Question: Does the figure show an increasing or a decreasing trend?
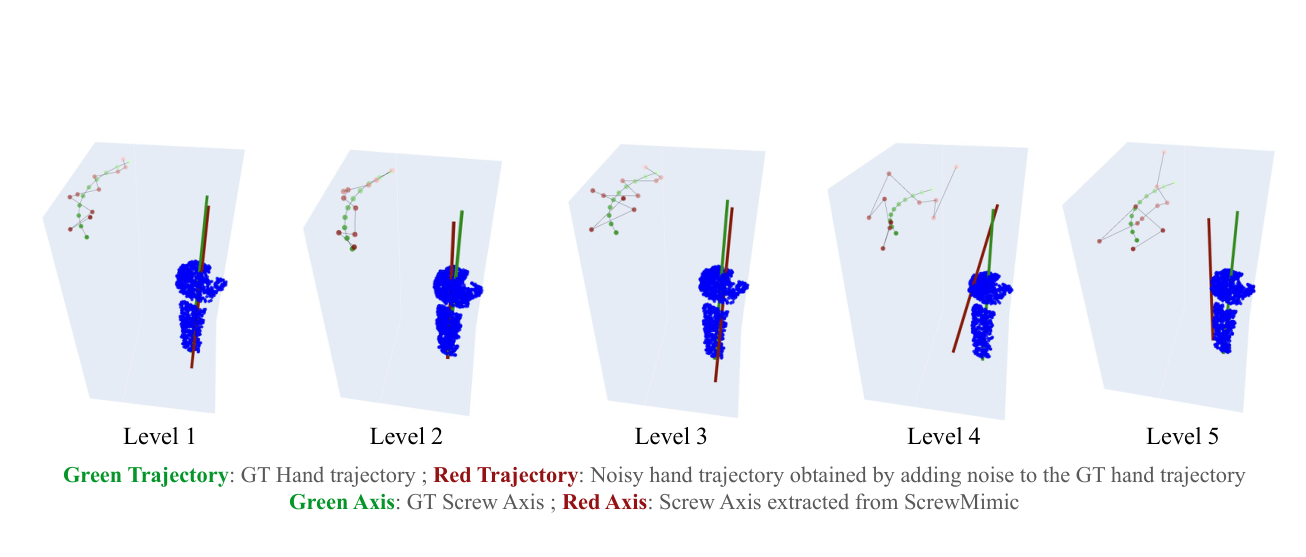
Answer: increasing